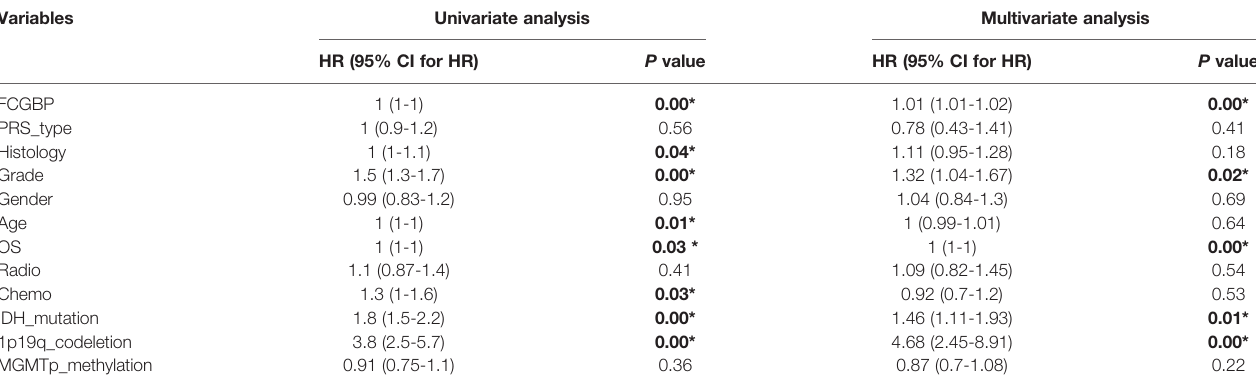
TABLE 2 | Cox regression analysis of the clinical variables, and overall survival in CGGA